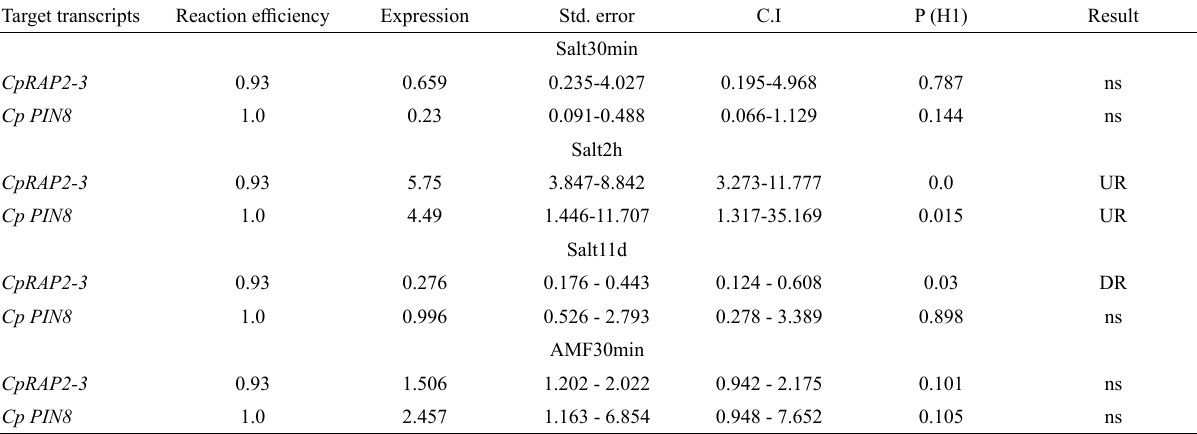
Table 4 – Relative expression calculated by REST software of two target transcripts ( RAP2-3 and PIN8 ) for Salt30min, 2h, 11d and AMF30min in Cenostigma pyramidale